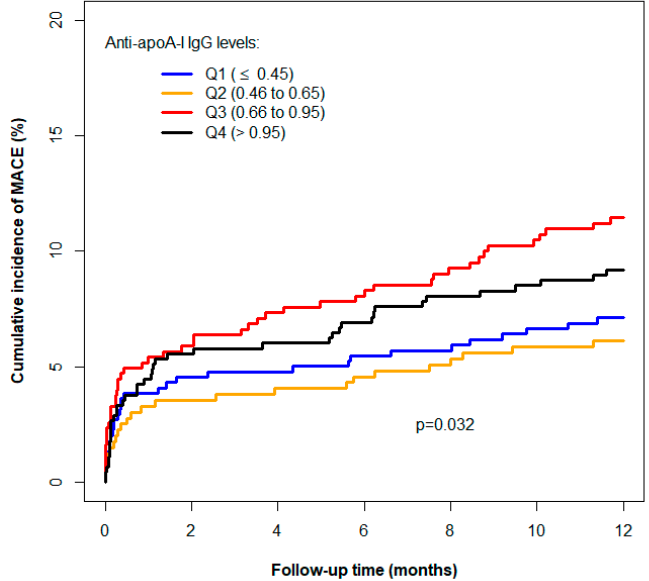
Figure 1. Cumulative incidence of major adverse cardiovascular events (MACE) (myocardial infarction, stroke, TIA, or cardiovascular (CV) death) according to autoantibodies against apolipoprotein A-I (anti-apoA-I IgG) optical density (OD) quartiles.